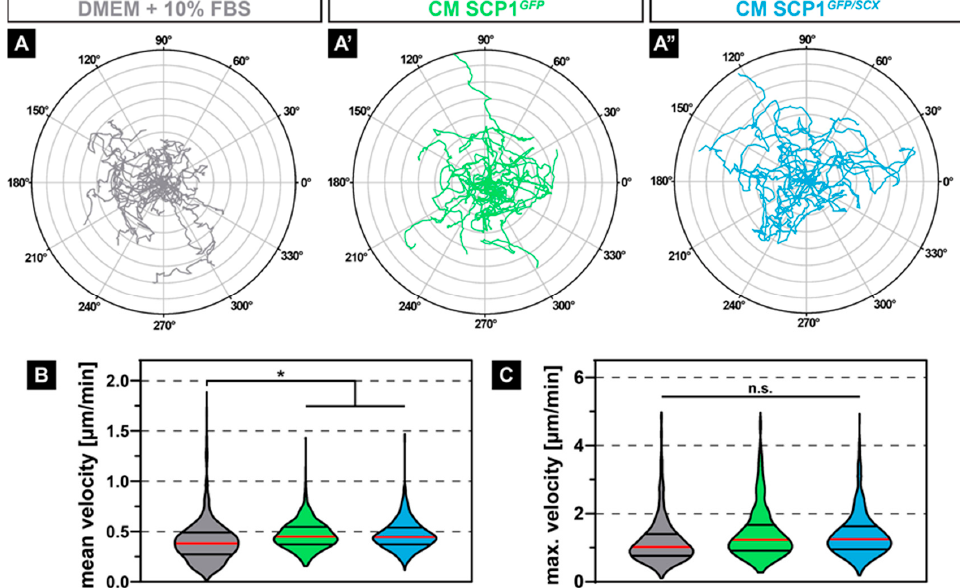
Figure 2. Polar plots of 20 exemplary cell migration tracks showed increased random migration and a longer Euclidian distance of myoblasts treated with conditioned media (CM) derived from SCP1 GFP or SCP1 GFP/SCX cells when compared to C2C12 in standard culture media ( A–A’’ ). Quantification of the migratory parameters confirmed the subjective appearance of the cell tracks, by revealing a significant increase in the mean velocity ( B ) with an unchanged maximum velocity ( C ). Distance of concentric circles: 50 µm. Vertical lines in violin plots represent the median (red) and quartiles (black). * equals p ≤ 0.05, n.s.: not significant. Data were obtained from three randomly selected field-of-views (FOV) of three independent experiments. At least 530 cells per experimental condition were evaluated.